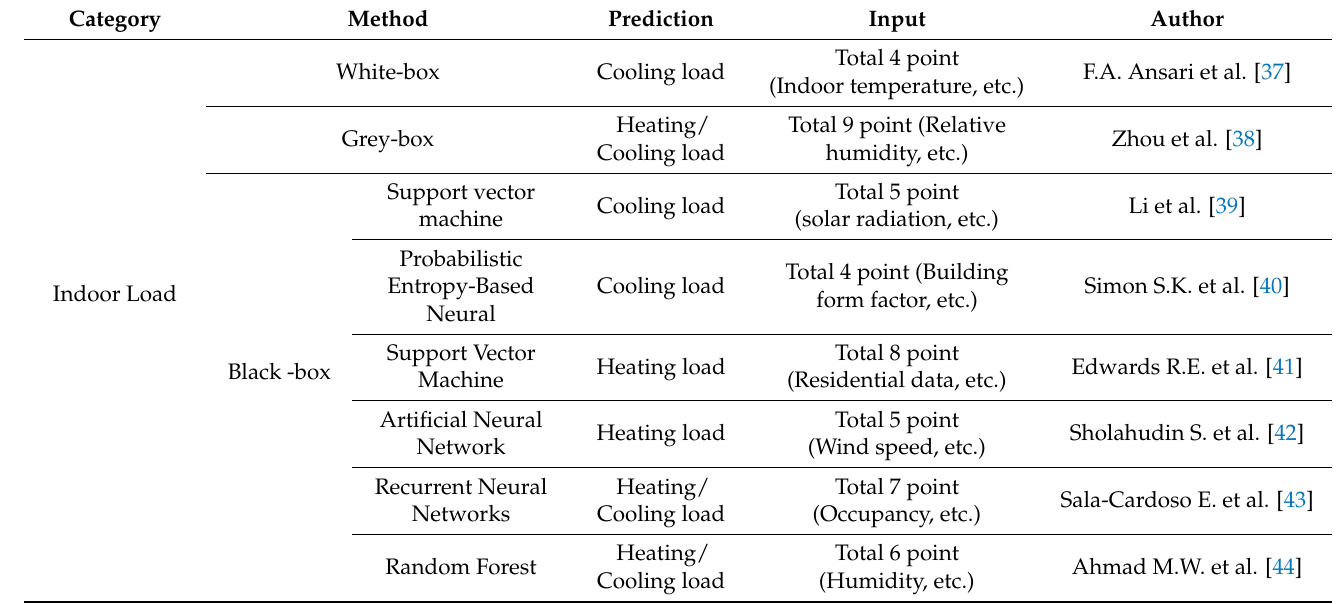
Table 2. Existing study of indoor load prediction